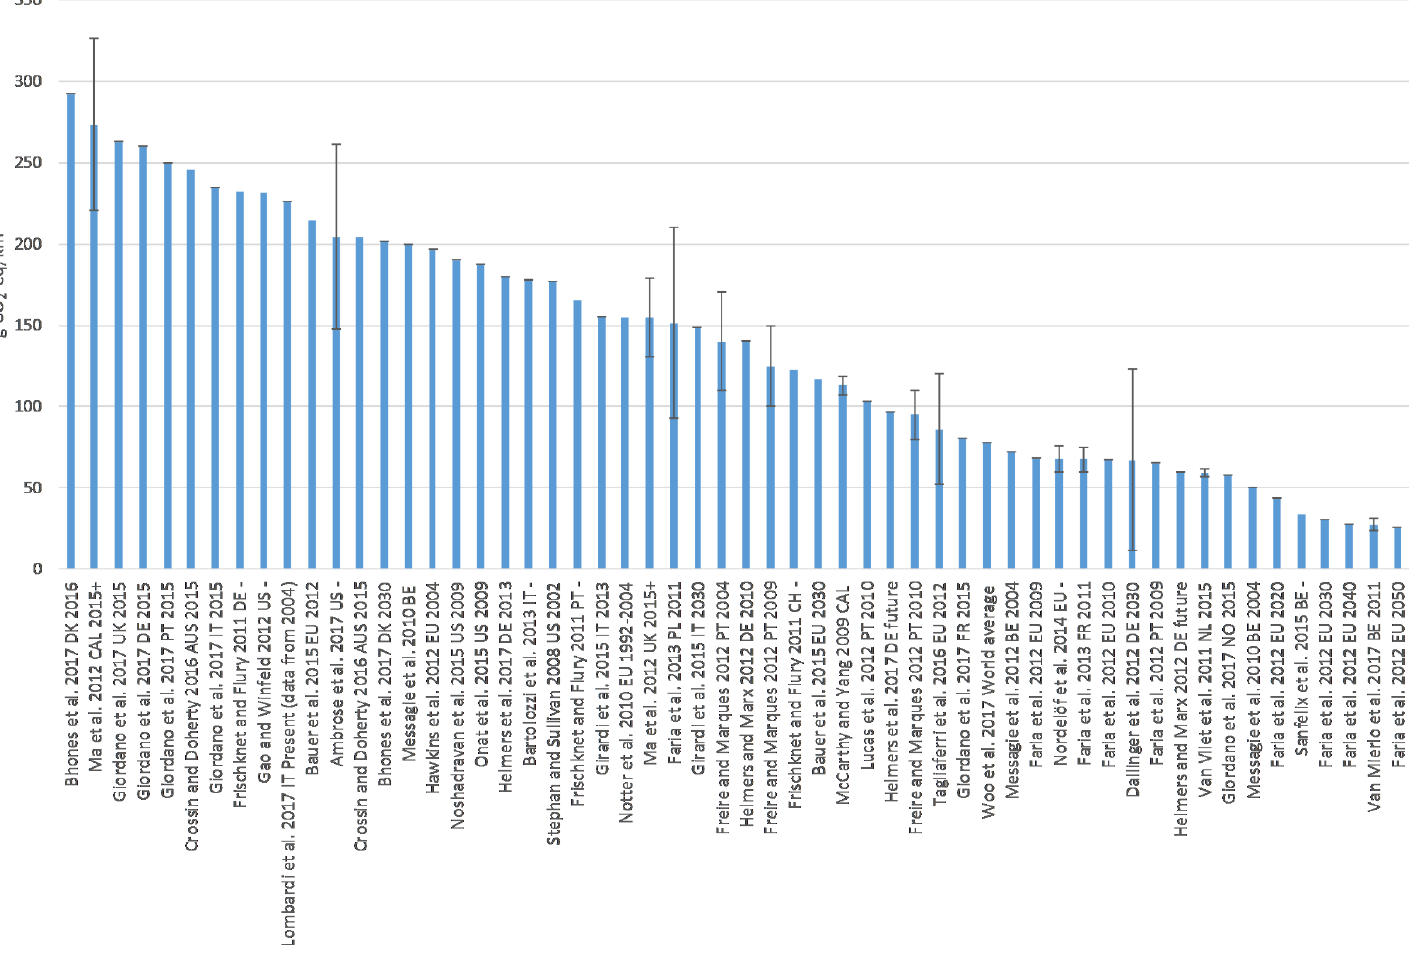
Figure 8. Literature results normalised at the most common indicator “g CO 2 -eq/km” (blue bars). If a study presents more than one value, the average value has been reported (blue bar) with the associated range.